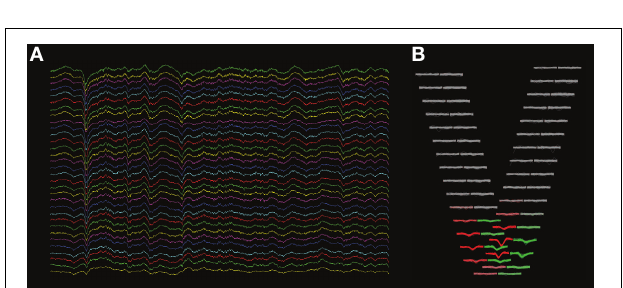
varying variables (here, the point’s color) that are passed to the fragment shader. The vertex shader implements linear or non-linear transformations (here, a rotation and a scaling) and is written in GLSL. Primitives (here, three line segments) are constructed in the primitive assembly. (B) During rasterization, a bitmap image is created out of these primitives. The fragment shader assigns a color to every drawn pixel in parallel. Varying variables passed by the vertex shader to the fragment shader are interpolated between vertices, which permits, for example, color gradients.